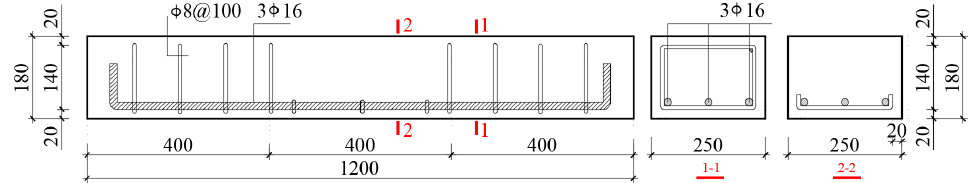
Figure 4. Information of the research objects (units: mm). Table 2. Mix proportion of concrete (kg/m 3 ).